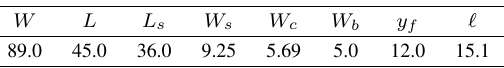
FIGURE 23. (a) Impedance matching and broadside AR measured performance for the final CP Reconfigurable E-shaped patch. (b) Magnified view of the switch implementation with the conductive paint bias lines. Adapted from